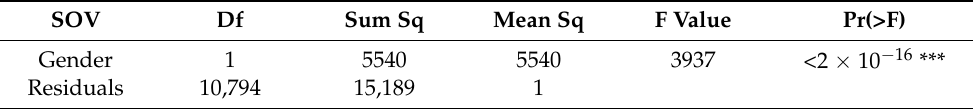
Table 3. ANOVA of P. orientalis strobili (seed cones and pollen cones) production. SOV Df Sum Sq Mean Sq F Value Pr(>F) Gender 1 5540 5540 3937 <2 × 10 − 16 *** Residuals 10,794 15,189 1